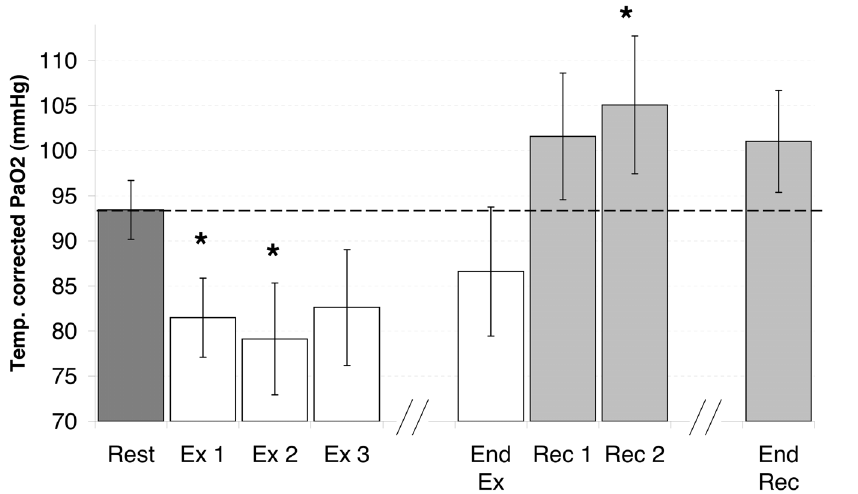
Figure 5. Mean ± SEM of temperature-corrected arterial oxygen pressure. Ex1, Ex2, Ex3 and End Ex are minutes 1, 2, 3 and the end of exercise. Rec1, Rec2 and End Rec are minutes 1, 2 and the end of recovery. *p , 0.05 vs. rest.